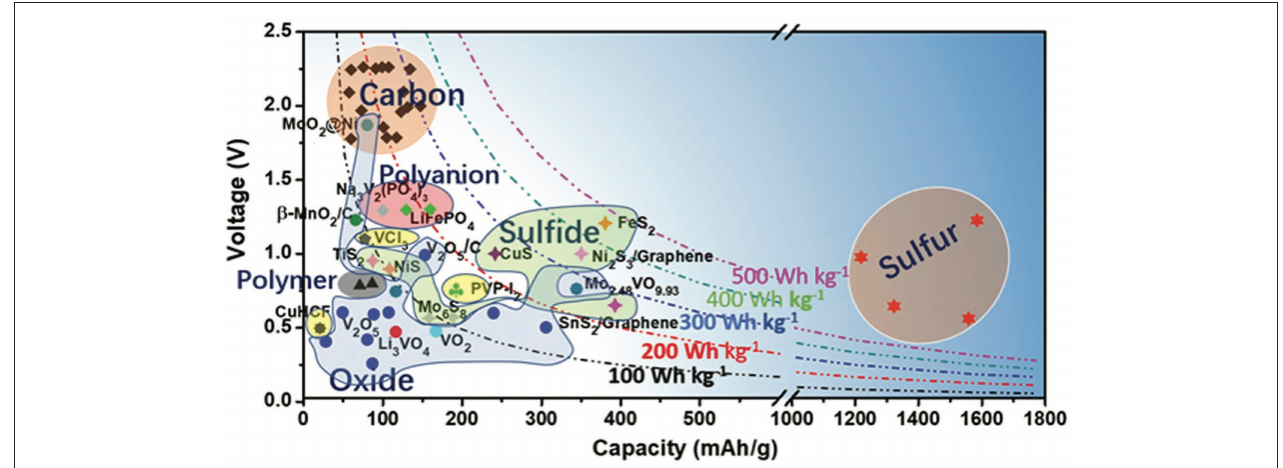
FIGURE 8 | Capacity vs. voltage for reported positive electrodes for non-aqueous aluminum batteries. The dots present the practical average discharge voltages and the corresponding available specific capacities of each material. It has to be noted that these materials have not necessarily been proven to intercalate Al 3 + but chloroaluminate ions, such as AlCl − 4 , instead. Figure reproduced with permission from Zhang et al. (2018) © 2018 WILEY-VCH Verlag GmbH & Co. KGaA,